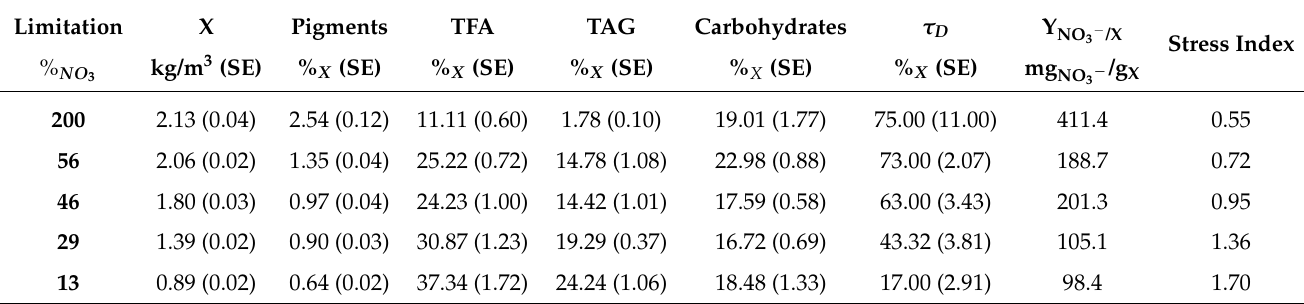
Table 2. Physiological changes of N. gaditana at steady state for several levels of nitrogen limitation. SE for standard error with n =